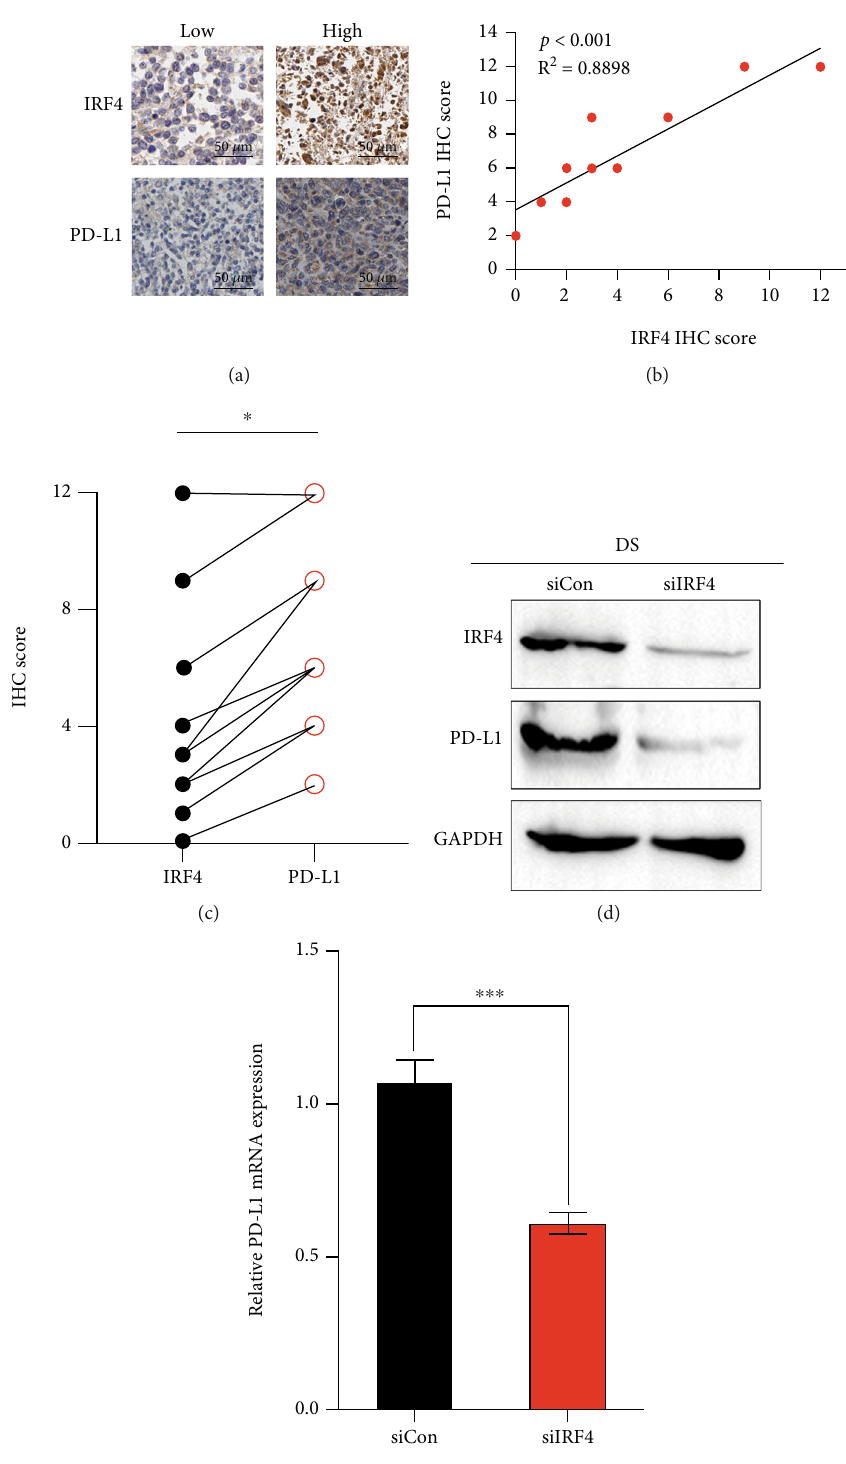
Figure 5: (a) IHC was used to detect the expression of IRF4 and PD-L1 in DLBCL. Two cases were stained with IRF4 and PD-L1 immunohistochemistry. Examine the section under a microscope. (b) The images described are representative of 30 cases of DLBCL. Correlation between IRF4 IHC score and IRF4 IHC score in 30 DLBCL patients, calculated by Spearman ’ s rank correlation methods, in 30 DLBCL cases. (c) We transfected siControl and siIRF4 into DS cell line by transient transfection method. Proteins were collected and lysed, and the displayed proteins were analyzed by western blotting. (d) The expression of PD-L1 was detected by real-time fl uorescence quantitative PCR. The error bar represents three separate